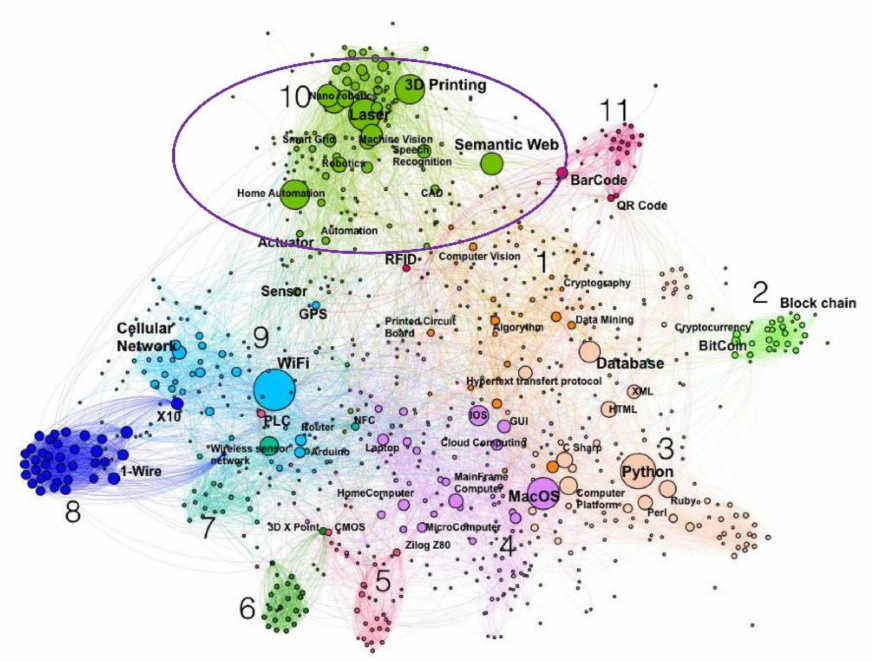
Figure 2. Graphical representation of Industry 4.0 technologies and their arrangement in the form of clusters [18]. Reproduced with permission from Ref. [18]. Copyright (2018), Computers in